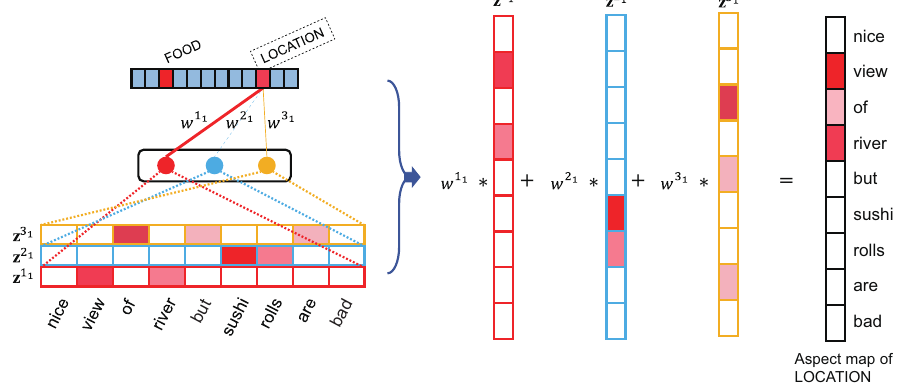
Figure 6. Extraction of an aspect map from AMEN. Here, the aspect map for LOCATION is